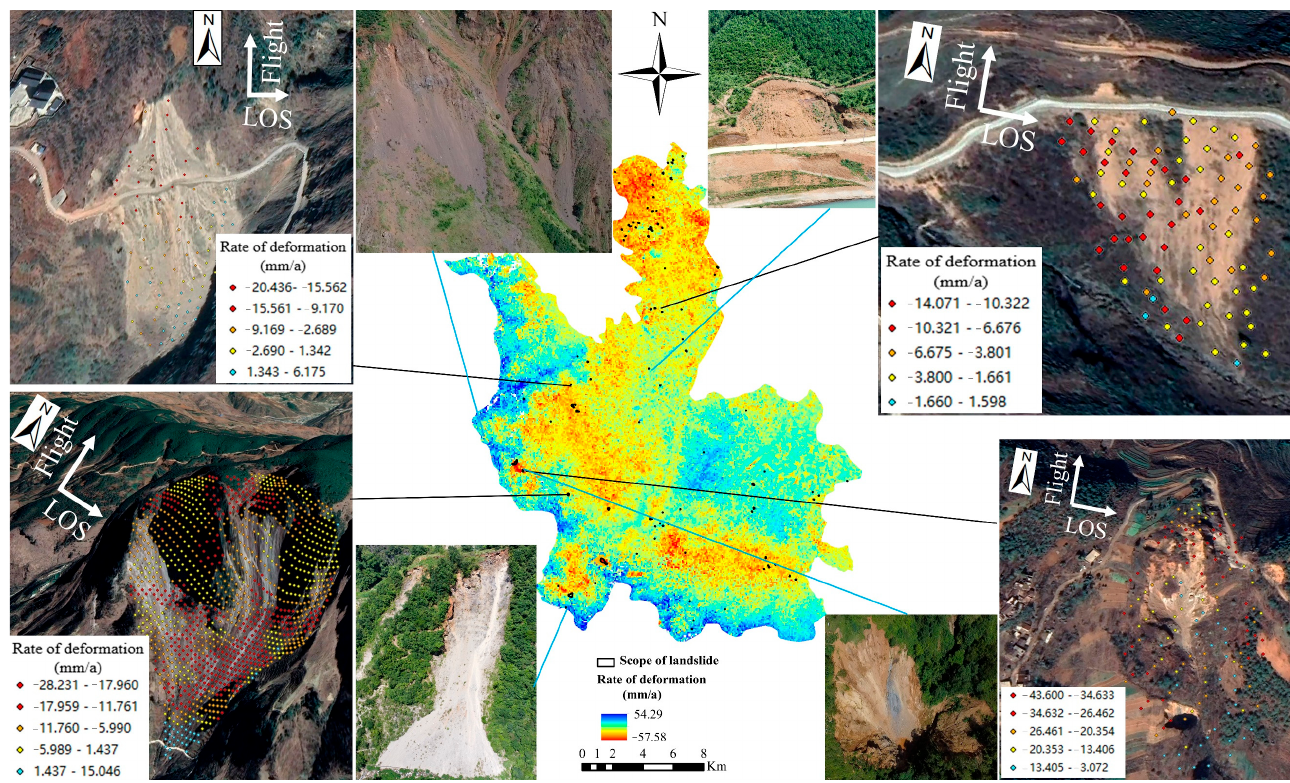
Figure 6. Surface deformation and landslide identification of study area (descending orbits).